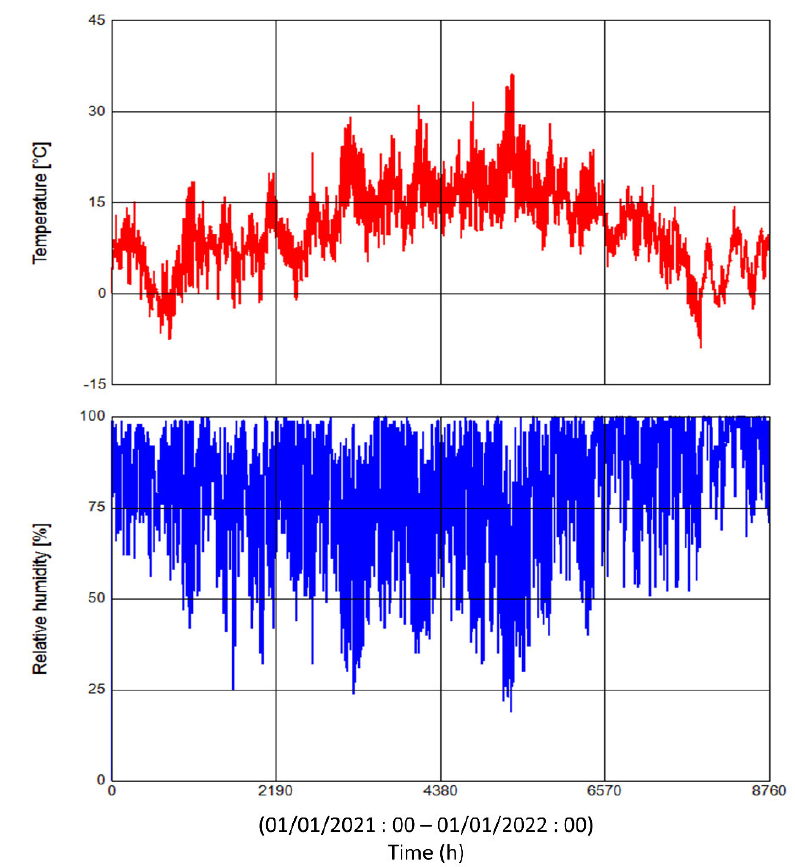
Figure 15. Climatic conditions.